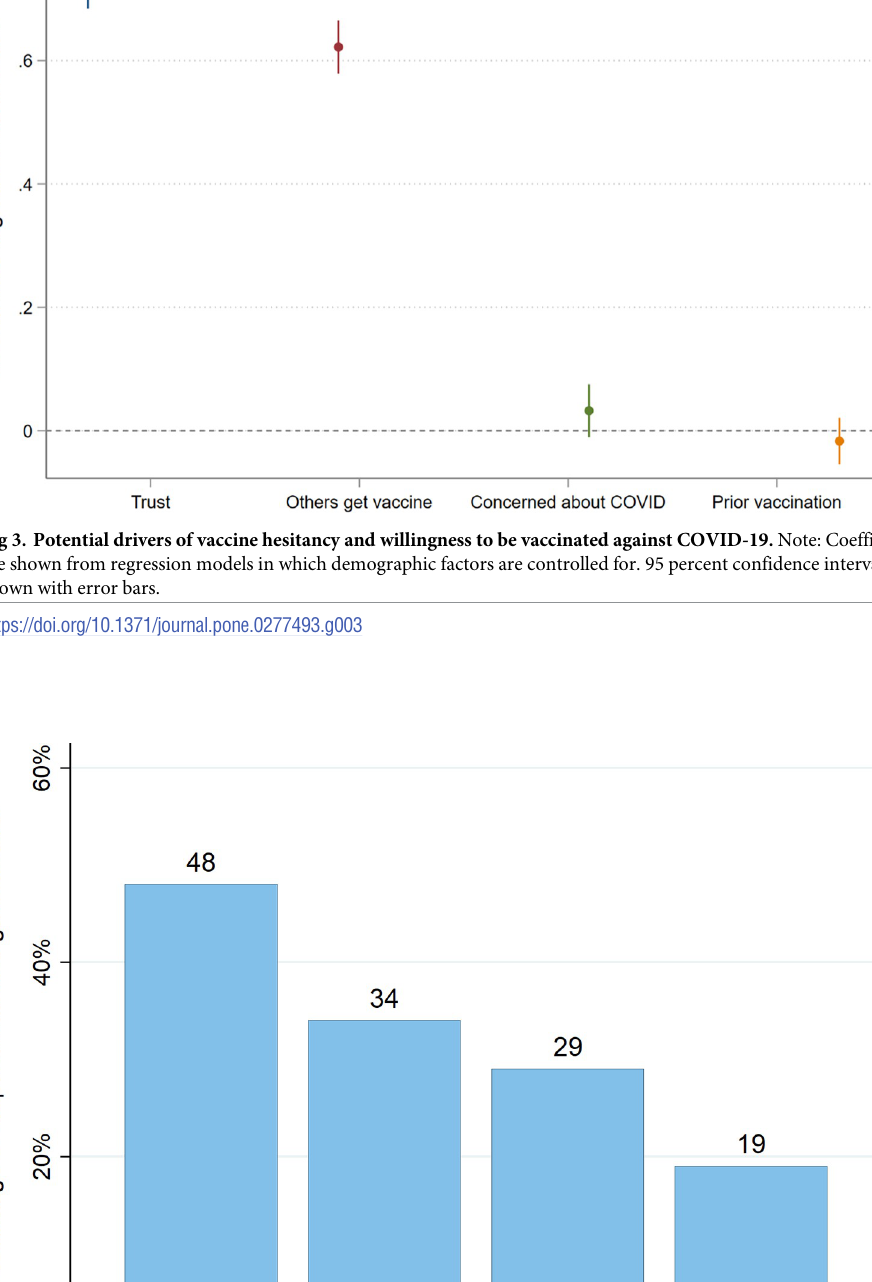
PLOS ONE | https://doi.org/10.1371/journal.pone.0277493 November17,